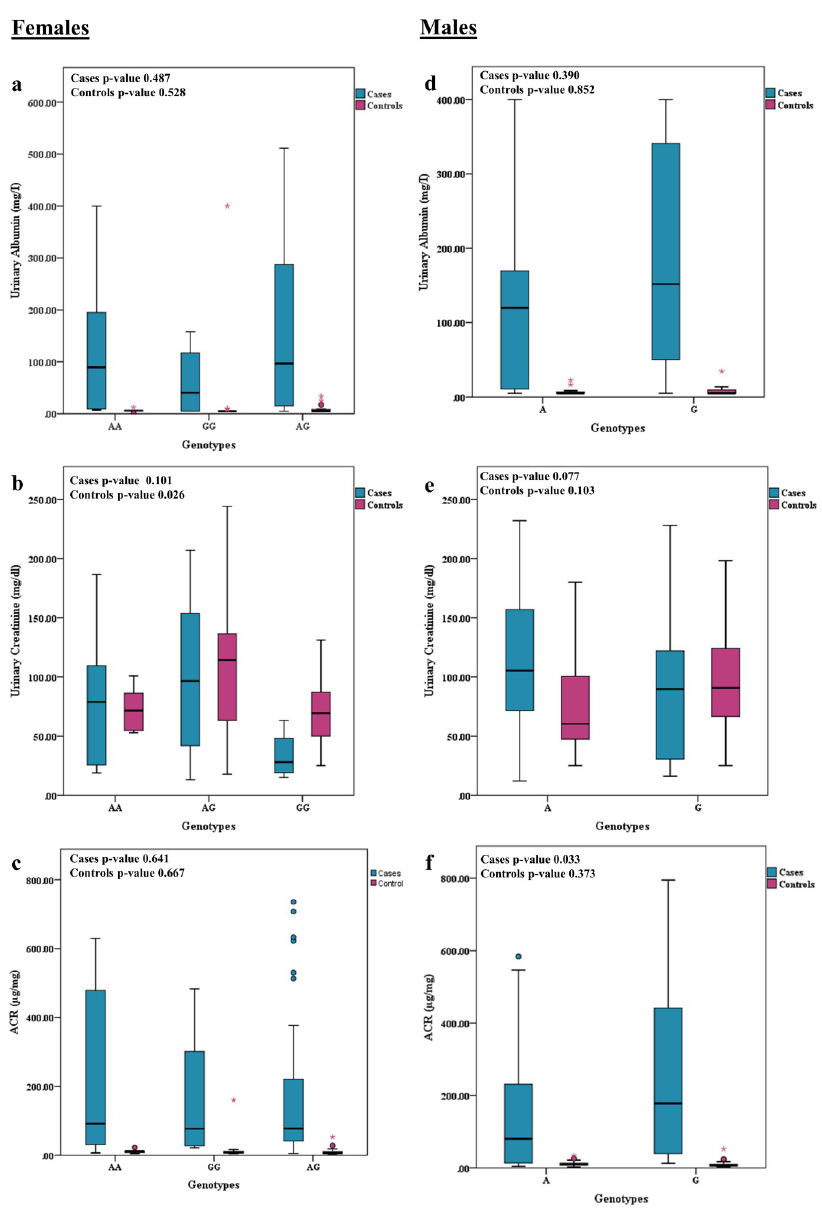
Fig 2. Association of G8790A ACE2 polymorphisms with the distribution of UAE, Urinary Creatinine and ACR data in controls and T2DM cases. a-c) Distribution of data according to female genotypes (GG/AG/AA) d-f) Distribution of data according to male genotypes